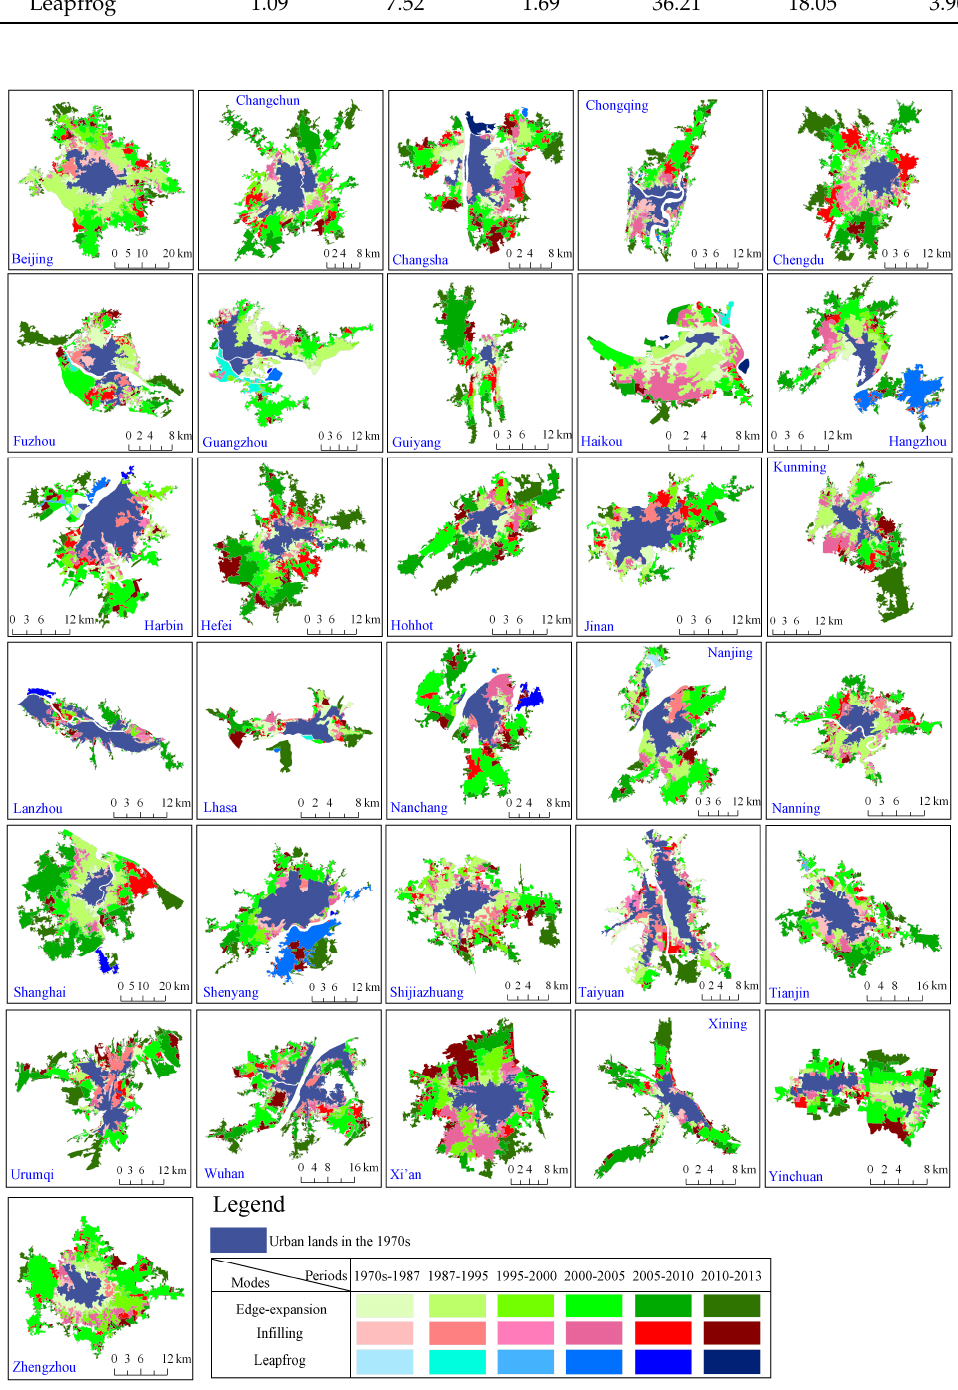
Figure 7. Temporal evolution of urban expansion forms in the 31 sample cities from the 1970s to 2013. Urban expansion in the leapfrog form only occurred in 14 cities, namely, Guangzhou, Harbin, Changsha, Haikou, Shenyang, Lhasa, Hangzhou, Nanchang, Chongqing, Fuzhou, Lanzhou, Nanjing, Shanghai, and Tianjin; less than half of the total number of cities under monitoring (Figures 6 and 7). The contribution rate of the leapfrog form to urban expansion was between 0.71% and 23.53%, and cities with a higher contribution rate were mainly distributed in East China, where urban expansion freedom was high. The rate of leapfrog expansion fluctuated (Table 1). Two peaks (1987–1995 and 2000–2005) occurred during the acceleration period of urban expansion. However, the variation